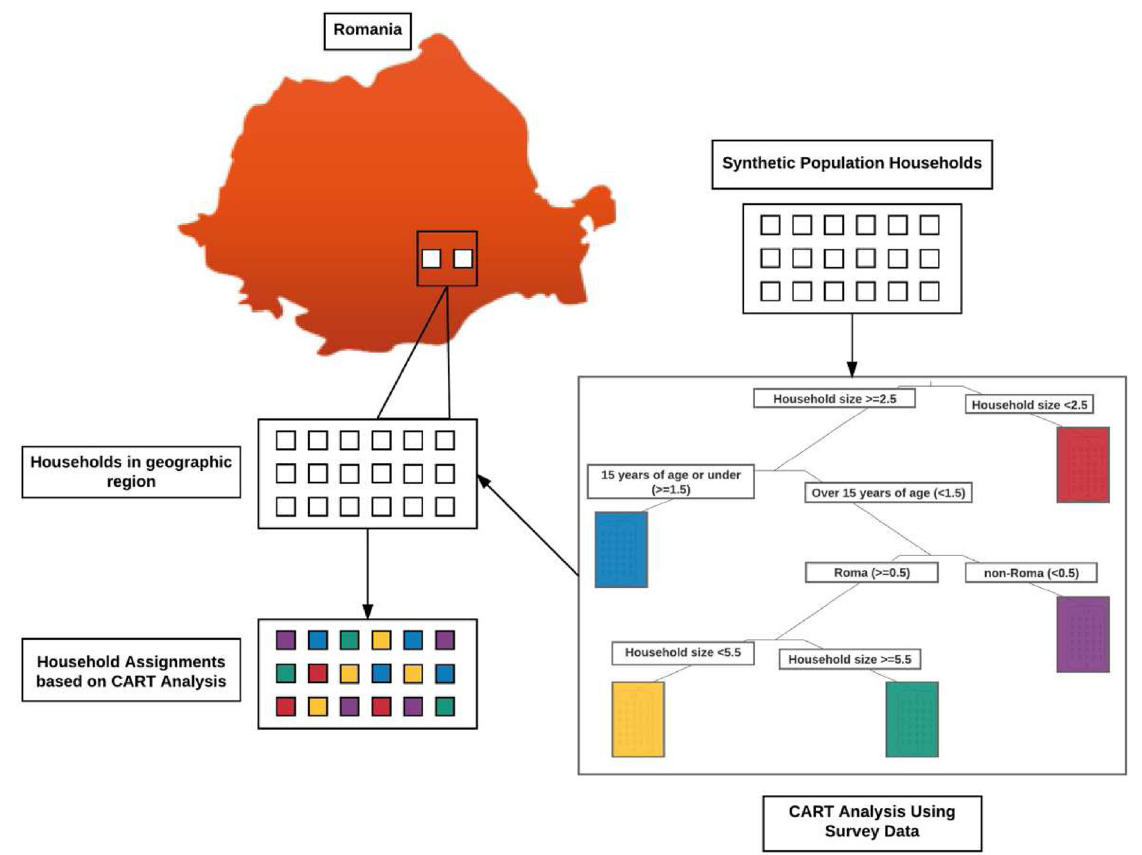
Figure 2. Work-flow for CART Analysis and categorical variable assignment in synthetic population.